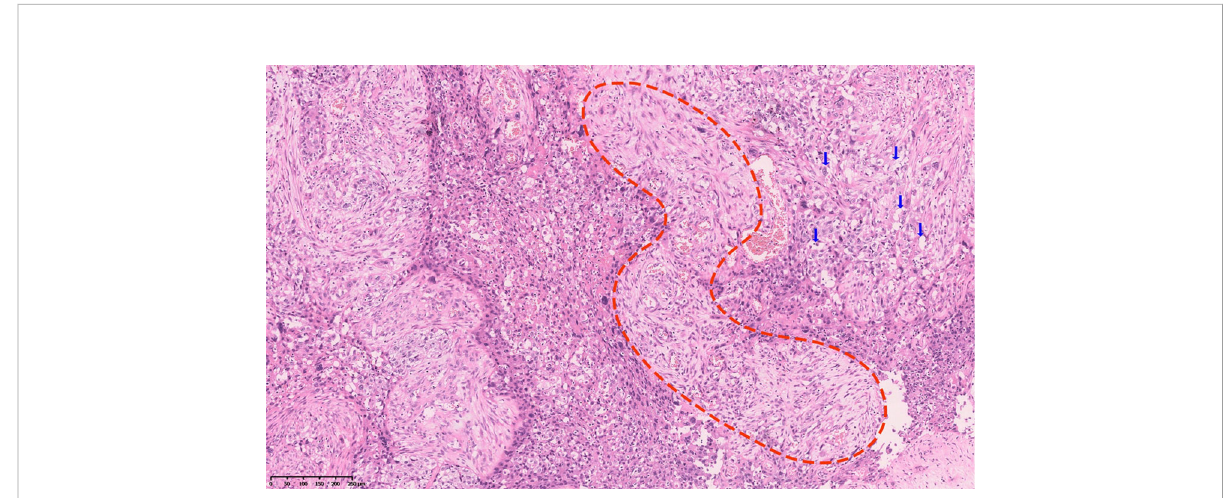
FIGURE 2 Histopathologic diagnosis: urothelial carcinoma of the right renal pelvic with sarcomatoid carcinoma differentiation. Conventional invasive high- grade urothelial carcinoma components (arrows) and sarcomatoid components (dotted circle).